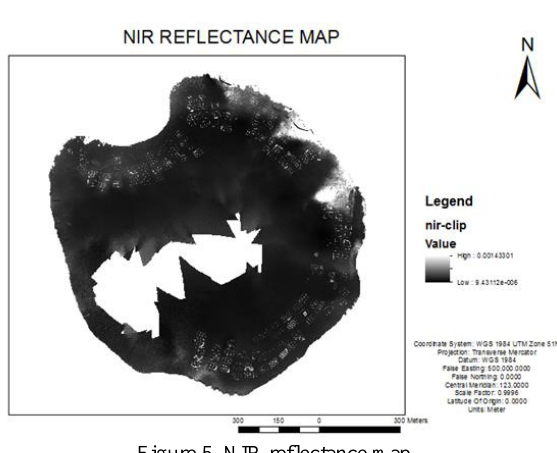
Figure 4. Red edge reflectance map